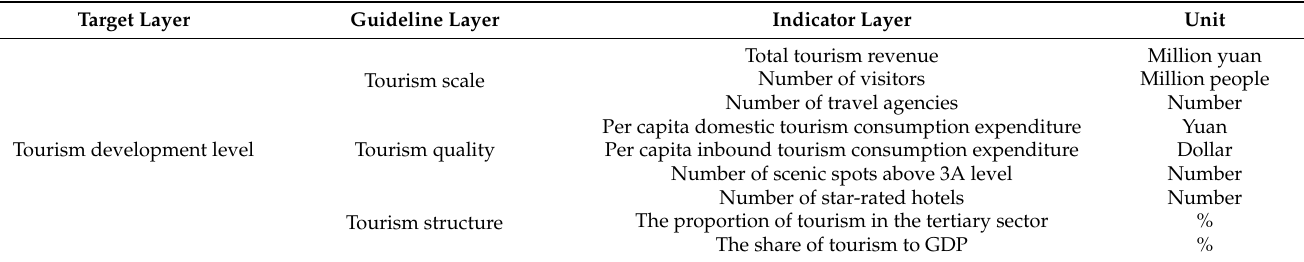
Table 2. Tourism development evaluation index